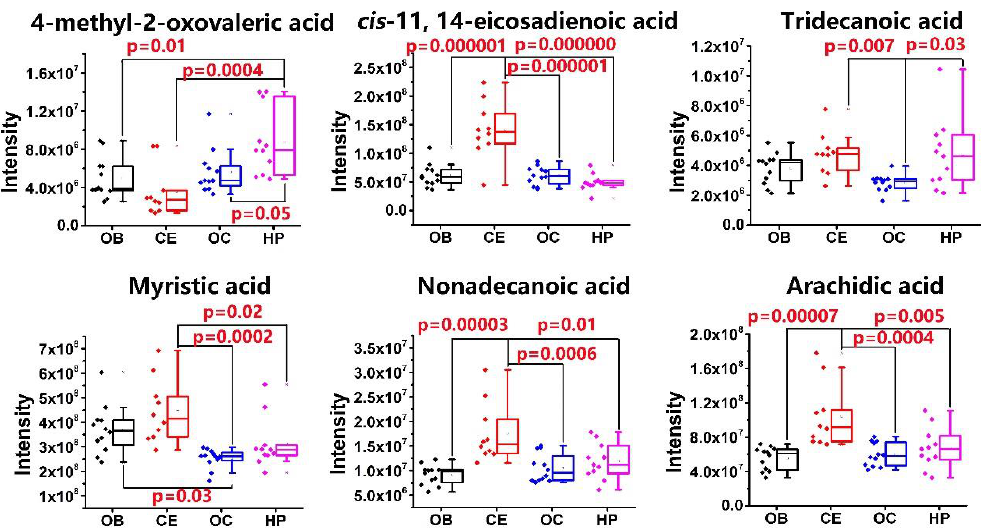
Figure 6. Relative concentration alternation of free fatty acids in 20 mg of rat. Boxplots and scatter plots of six significantly altered FFAs. p values were calculated by one-way ANOVA.